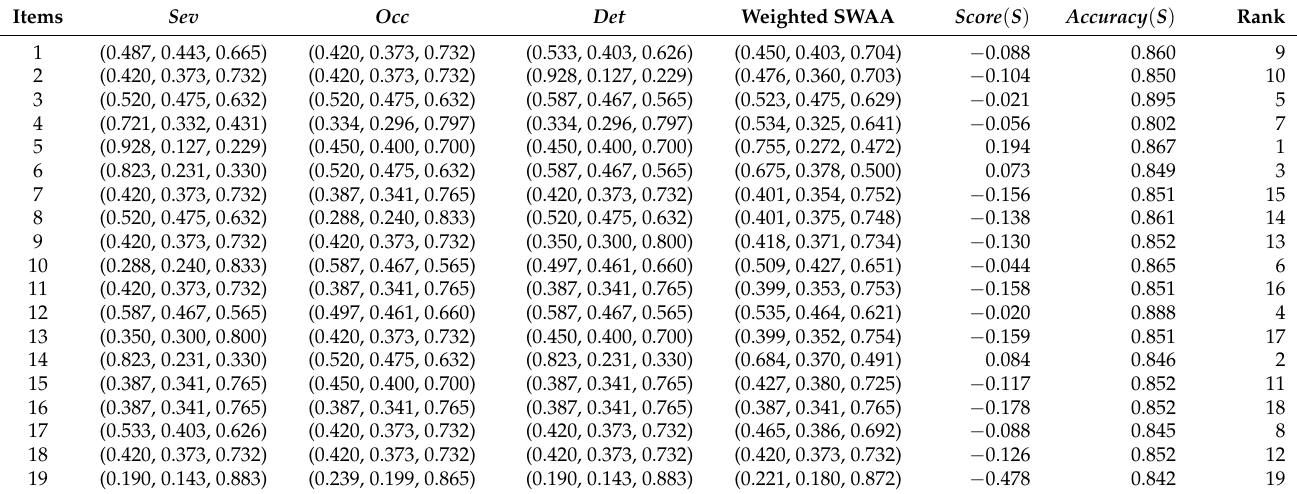
Table 7. The weighted SWAA, score, and accuracy values of the proposed